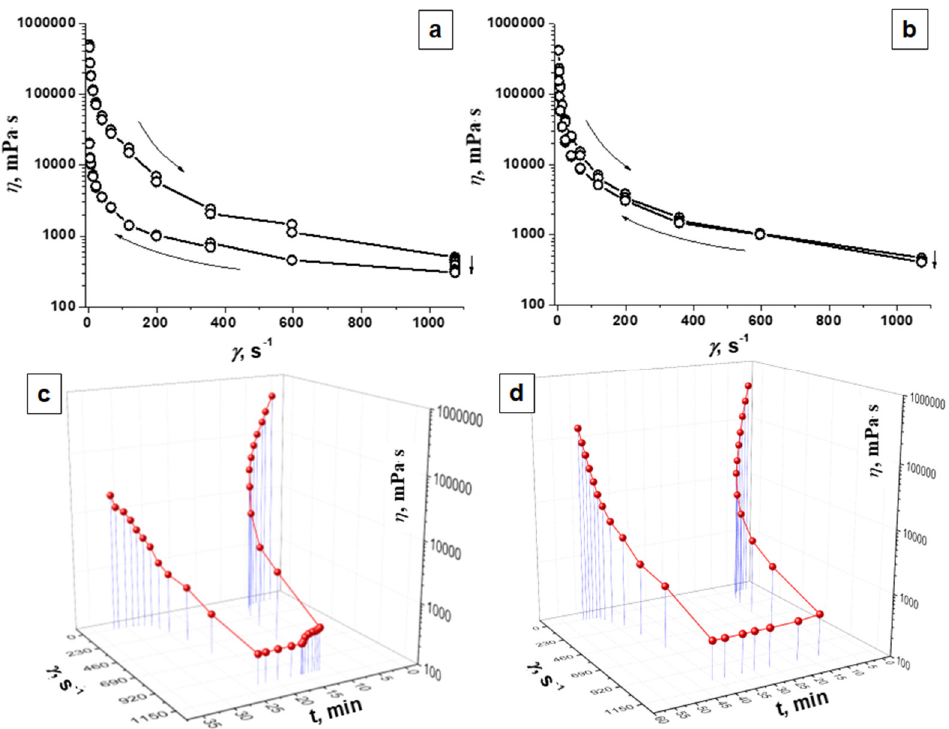
Figure 4. Dependence of effective viscosity ( η , mPa · s) of polyacrylamide gel (PAAG) ( b , d ) and agar gel ( a , c ) ( a , b )—on the shear rate ( γ , s −1 ); ( c , d )—on the shear rate ( γ , s −1 ) over time (t, min).